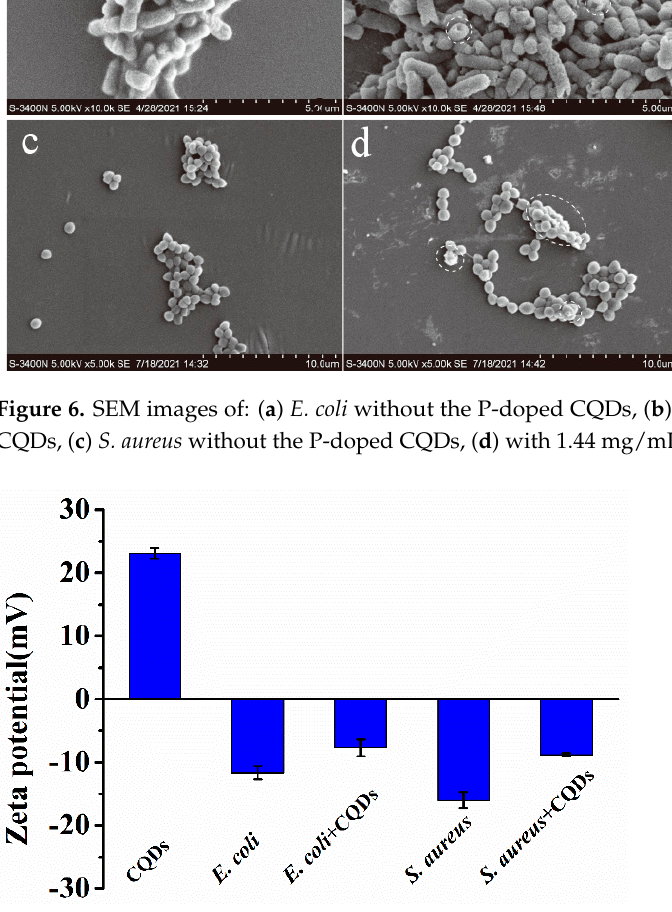
Figure 7. Zeta potentials of P-doped CQDs for E. coli and S. aureus without and with the P-doped CQDs treatment.